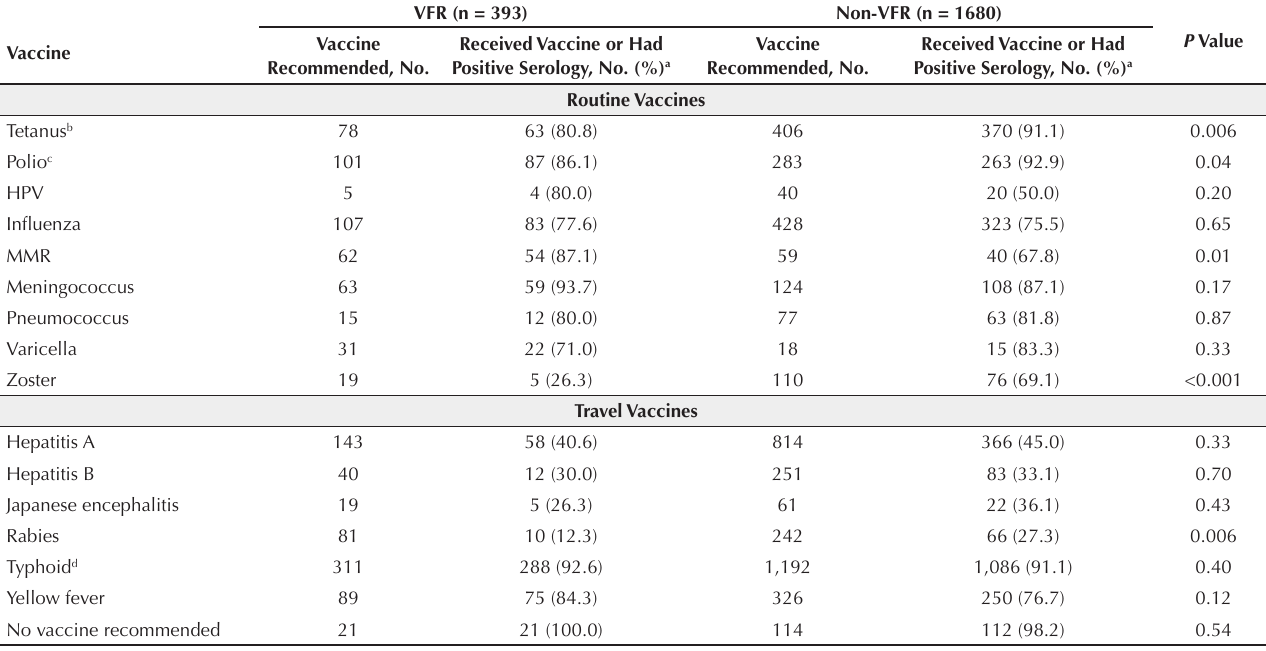
VFR (n = 393) Non-VFR (n = 1680)